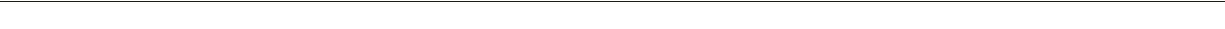
Fig. 1 Optimum time for Active conformation of the TCR at sub-saturating concentrations of the pMHC ligand. a Cartoon of the Resting and ligand-bound Active conformations of the TCR. Bivalent or multivalent ligation of two or more TCRs by its pMHC ligand results in an outside-in transmission of a conformational change detected in the cytoplasmic tails of the CD3 subunits. One of these changes consists in exposing an epitope in the proline-rich region of CD3 ε for mAb APA1/1 binding. b OT-1 CD8 + T cells were incubated at 37 °C with the indicated concentrations of APC-labelled OVAp tetramer for 24 h. After stimulation, cells were stained with anti-CD69 and analyzed by cytometry. The mean fl uorescence intensity (MFI) for CD69 staining is shown as red circles and that of tetramer binding as blue diamonds. c OT-1 CD8 + T cells were incubated on ice with the indicated concentrations of APC- labelled OVAp tetramer for 40 min. MFI was calculated by fl ow cytometry. d OT-1 CD8 + T cells were incubated at different times at 0 °C with 1 nM or 200 nM of OVAp-APC tetramer and subsequently fi xed, permeabilized and stained with the APA1/1 mAb prior to fl ow cytometry analysis. MFI for APA1/ 1 staining is shown as red circles and that of tetramer binding as blue diamonds. e OT-1 CD8 + T cells were incubated at different times at 37 °C with 1 nM OVAp-APC tetramer and stained with the APA1/1 mAb as in Fig. 1d. f Histogram overlay for APA1/1 expression in OT-1 and HY CD8 + T cells not incubated (blue lines) or incubated for 2 min (red line) or 5 min (brown line) with 1 nM OVAp-APC tetramer at 0 °C. All data shown in Fig. 1 represent the mean ± s.d. of triplicate datasets; * p < 0.05; ** p < 0.005; *** p < 0.0005 (two-tail unpaired t